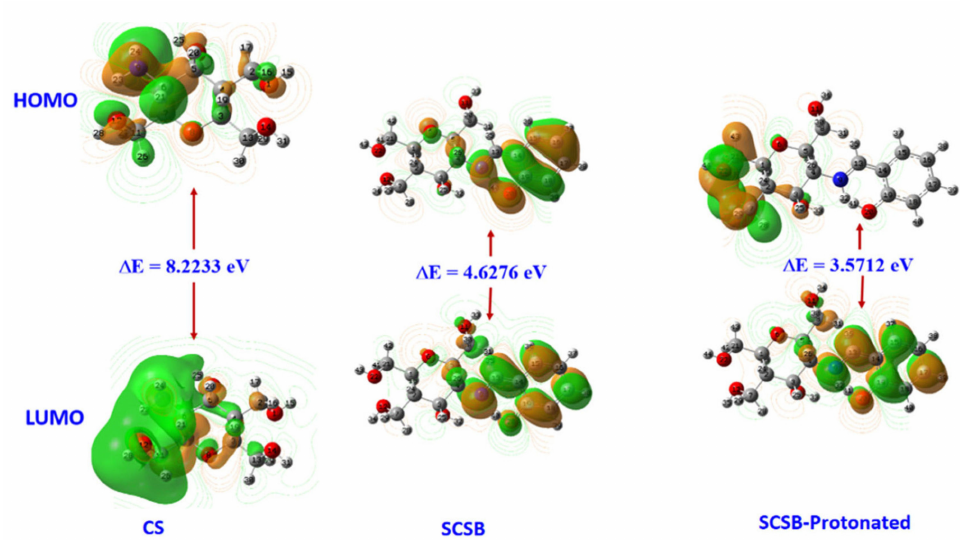
Figure 2. HOMO orbital, LUMO orbital and ∆ E of the three inhibitors (chitosan (CS), neutral (SCSB), and pronated salicylayde-chitosan Schiff Base (SCSB-Protonated)). (Reprinted with permission